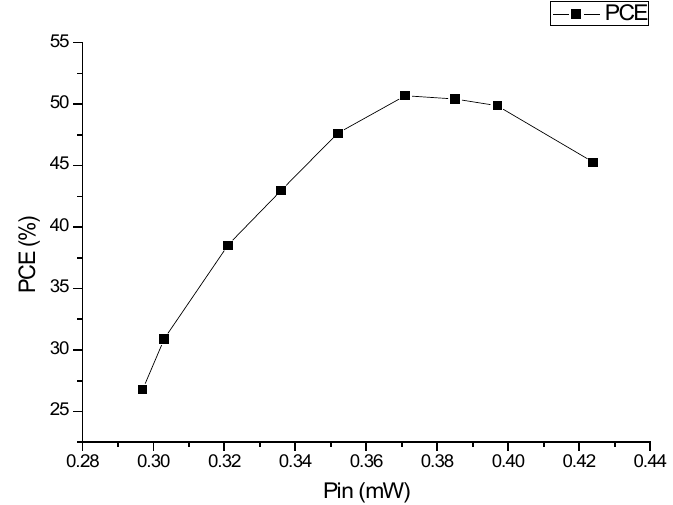
Figure 11. Test results of the PCE of the RF powering circuit in the HJTC 0.25 µm process.